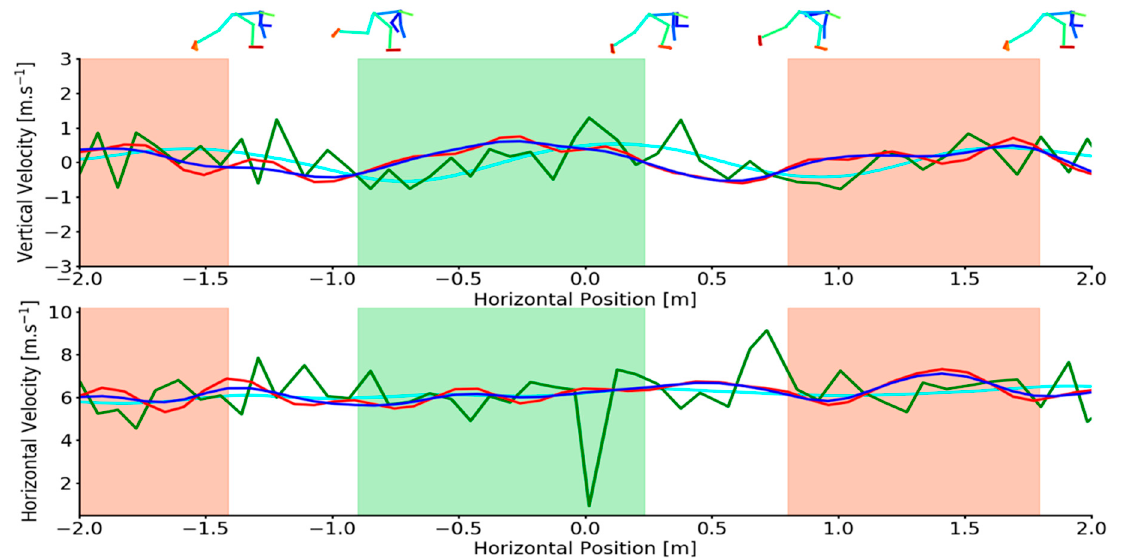
Figure 5. Upper-Example individual trial demonstrating vertical CoM velocities for criterion (cyan), unfiltered (green), low-pass filtered (red) and Kalman smoothed (blue) data as a function of horizontal CoM position during sprinting. Lower-Example individual trial demonstrating horizontal CoM velocities for criterion (cyan), unfiltered (green), low-pass filtered (red) and Kalman smoothed (blue) data as a function of horizontal CoM position during pushing. Shaded areas depict the left foot (red shading) and right foot (green shading) stance phase. Footfall events were computed from marker-based foot kinematics [31]. OpenPose joint centre reconstructions (top) at touch-down and toe-off events are overlaid for